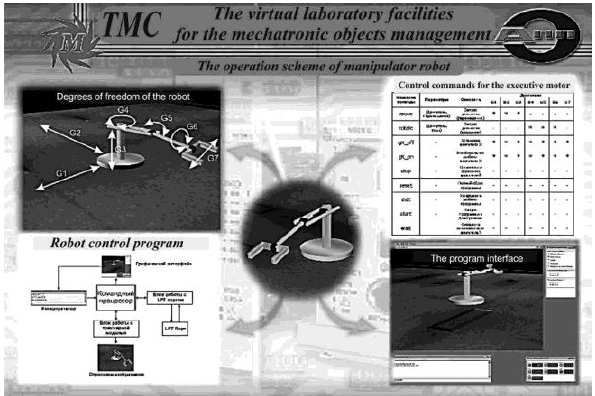
Figure 5. The virtual laboratory complex for